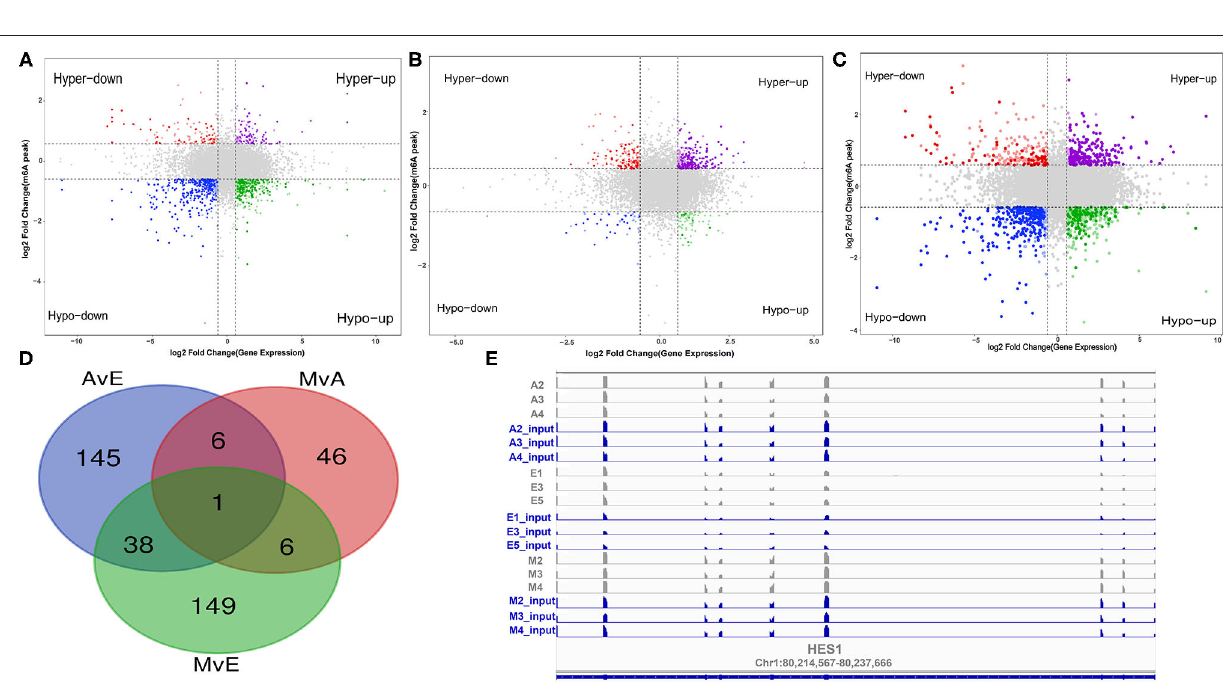
splicing, and endoplasmic reticulum lumen ( Figures 6B,E and Supplementary Table 7 ). In the M vs. A group, 194 negatively correlated modified genes were enriched in 17 KEGG